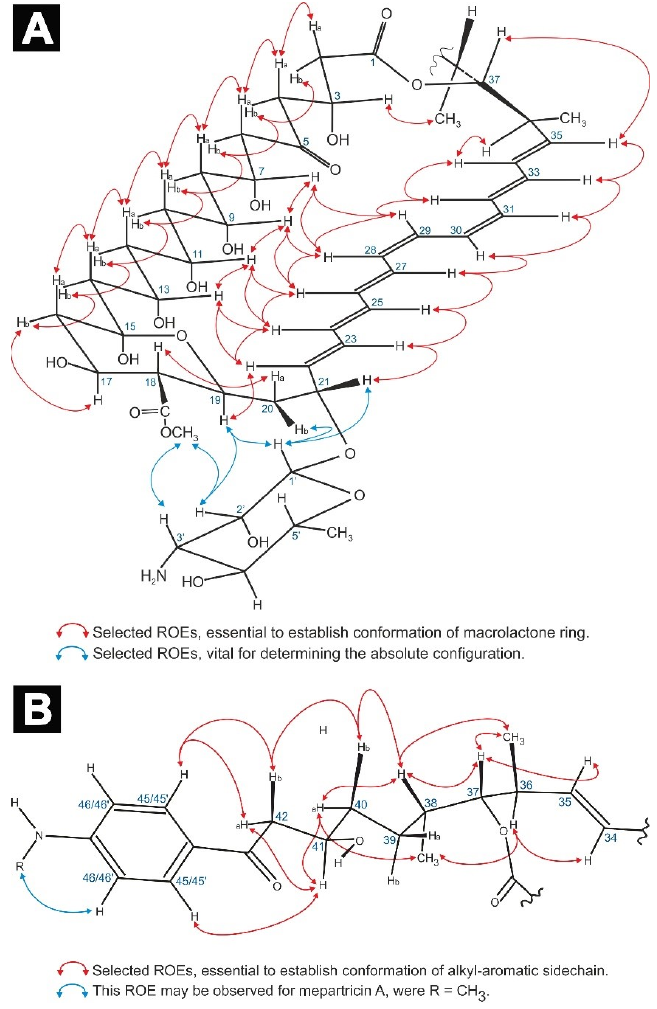
Figure 2. Selected ROEs, aiding the definition of the average conformation of the macrolactone ring ( A ) and alkyl-aromatic sidechain ( B ), as well as the relative and absolute configuration of all stereogenic centers of the studied molecules.